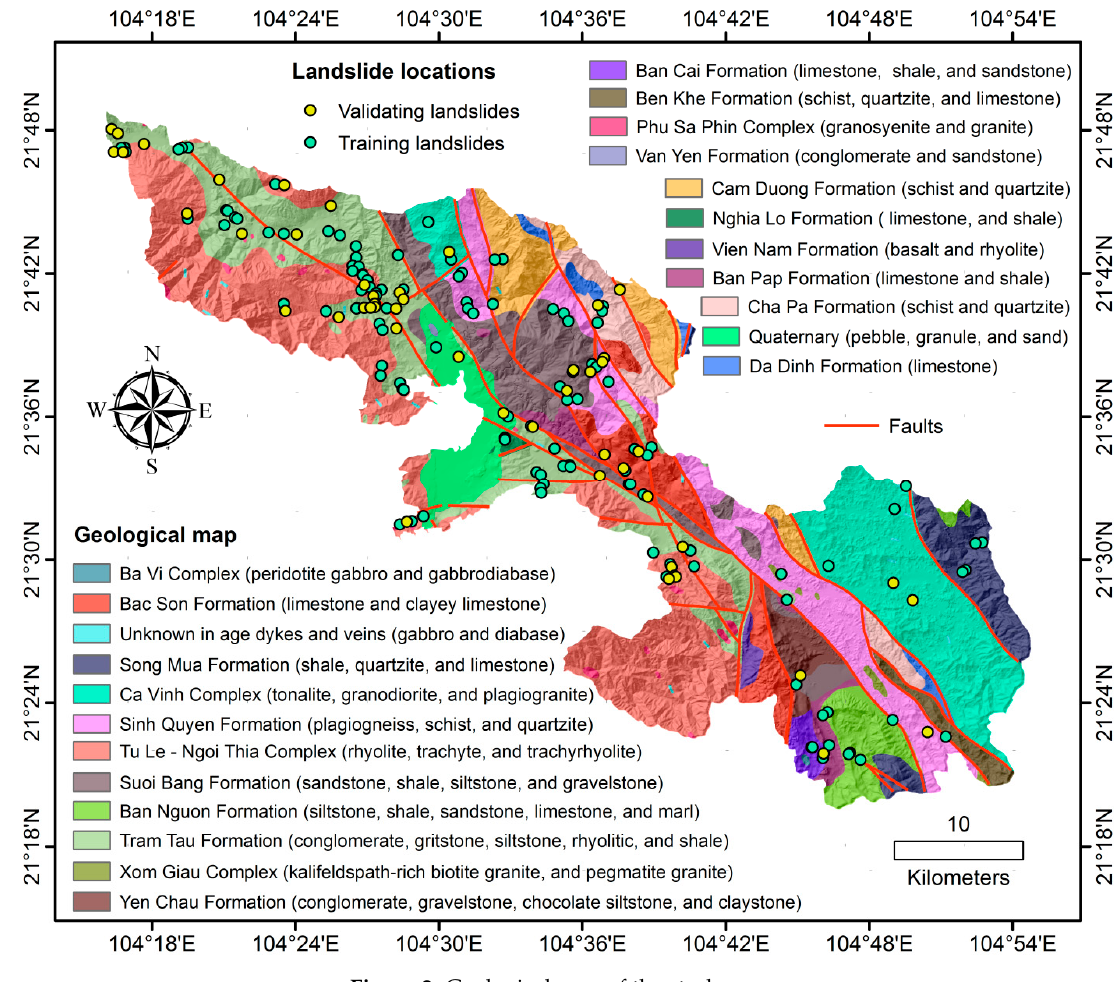
Figure 2. Geological map of the study area.